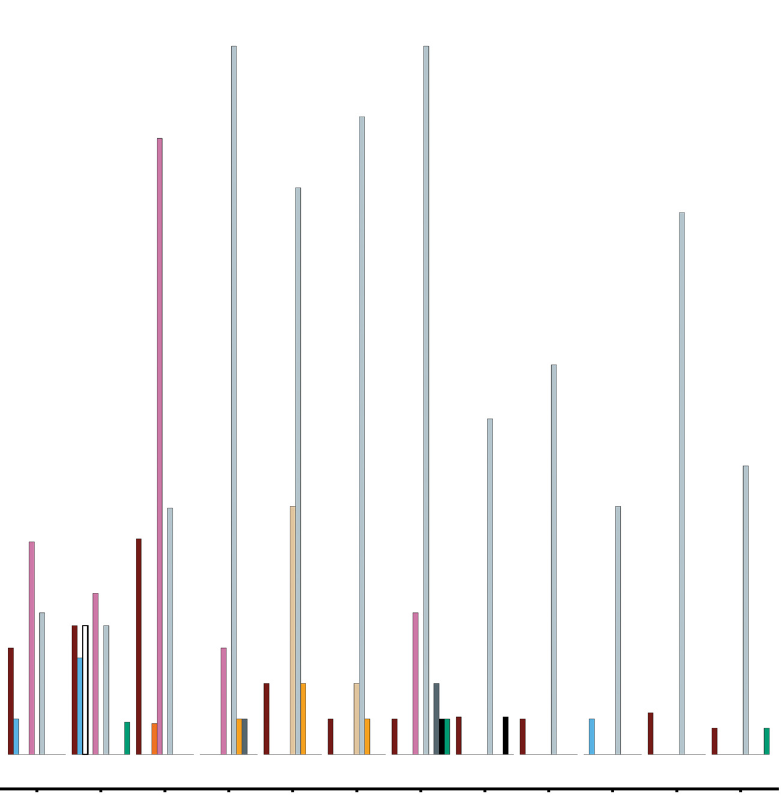
Fig 1. Infection prevalence (% host infected) for all parasite taxa found infecting P . volitans . Each taxon is identified by a specific color (see key). Latitude increases from left to right, and all sites are shown, except for the outlying back reef site in Galeta Point. Sample size (hosts examined) at each site ranged from 17 – 27; see Table 1 for details on collection effort. Species in legend with asterisk represent a new record for P . volitans